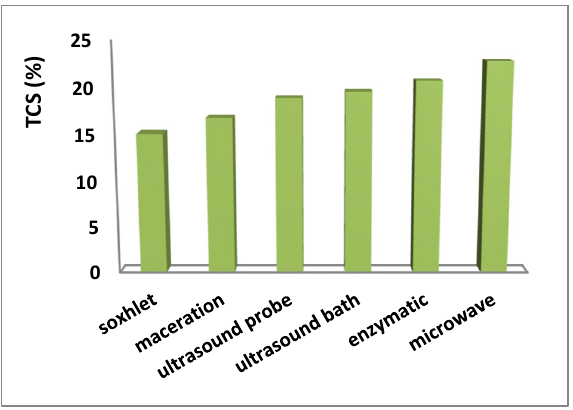
Fig. 3. Evaluation of different extraction methods on TSC